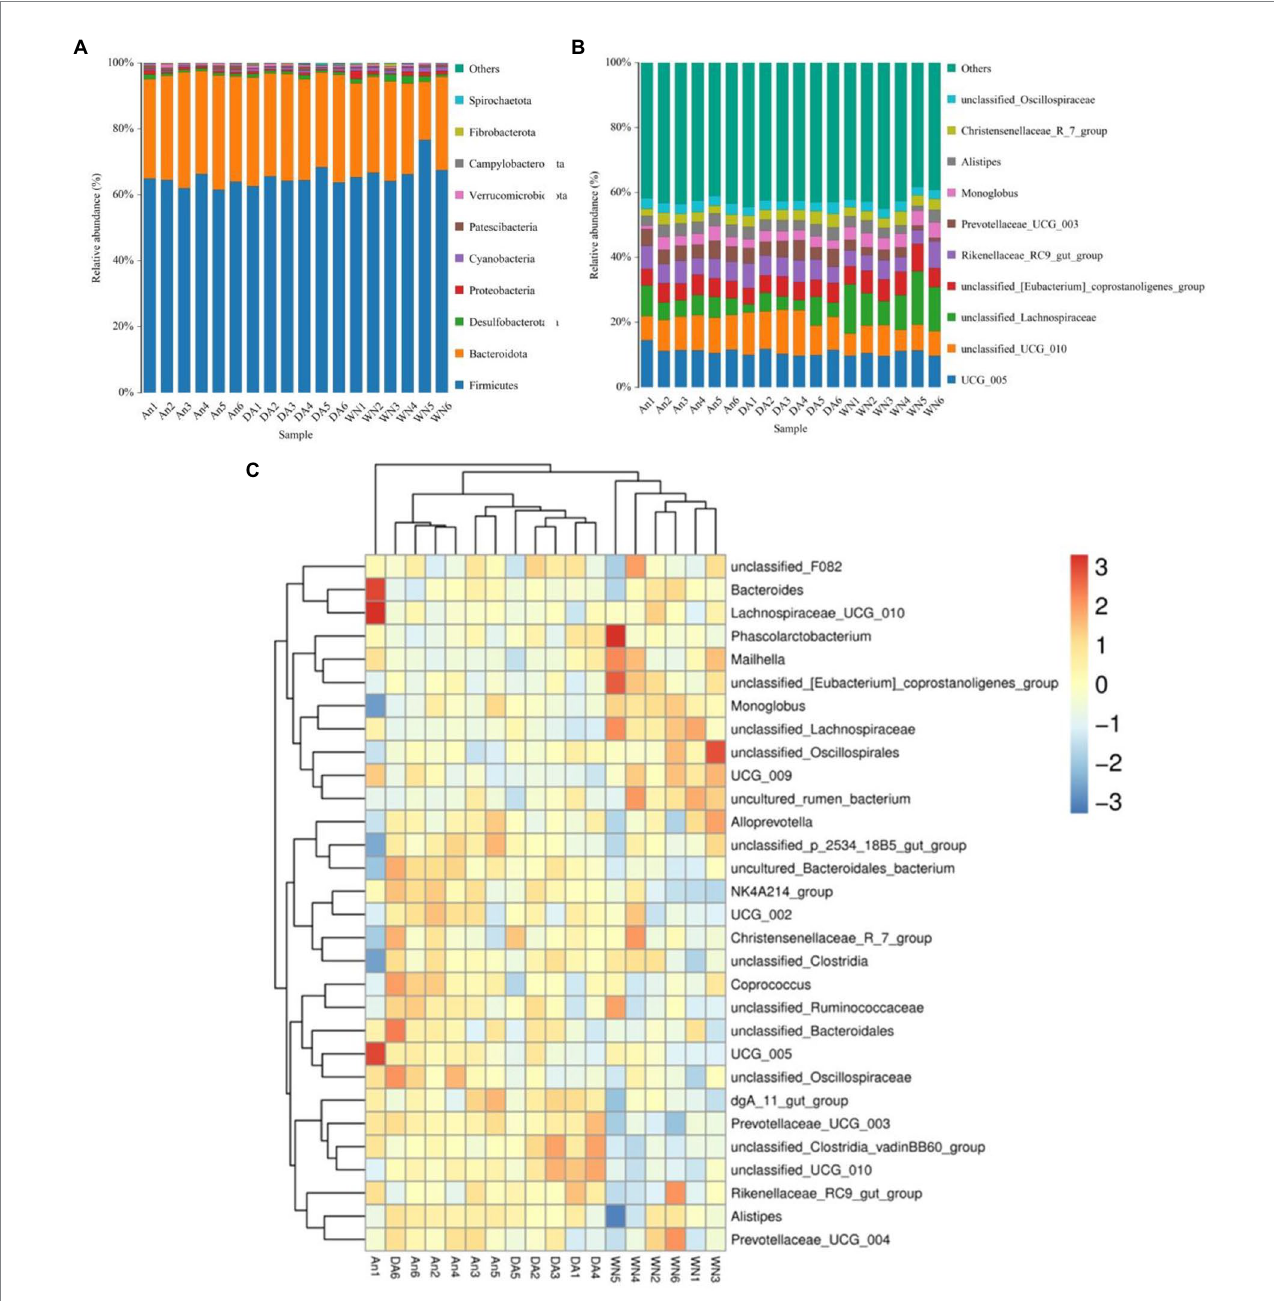
FIGURE 3 Changes of gut microbial composition associated with species and diarrhea. (A,B) Composition and the relative ratio of preponderant bacteria at the phylum and genus levels. (C) Heatmap of the 50 most abundant bacterial